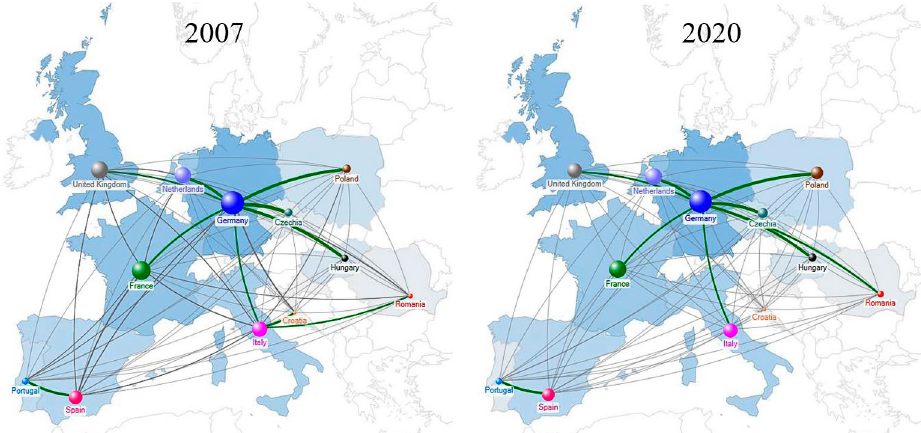
Figure 1. The evolution of trade relations between analysed countries (source: IMF, authors’